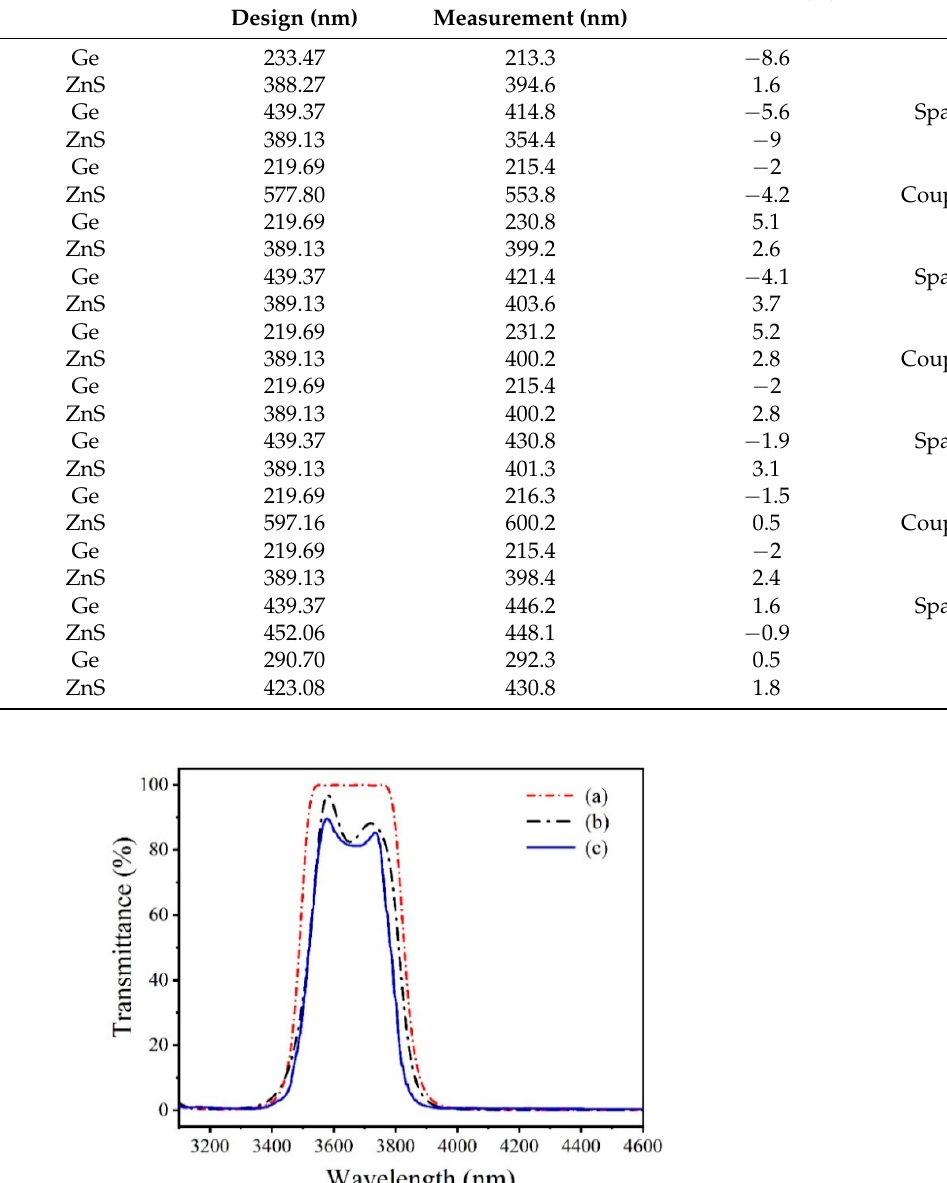
Table 2. Comparison of the film thickness between the designed and the measured multilayered filter for 3.55–3.75 µ m. Number of